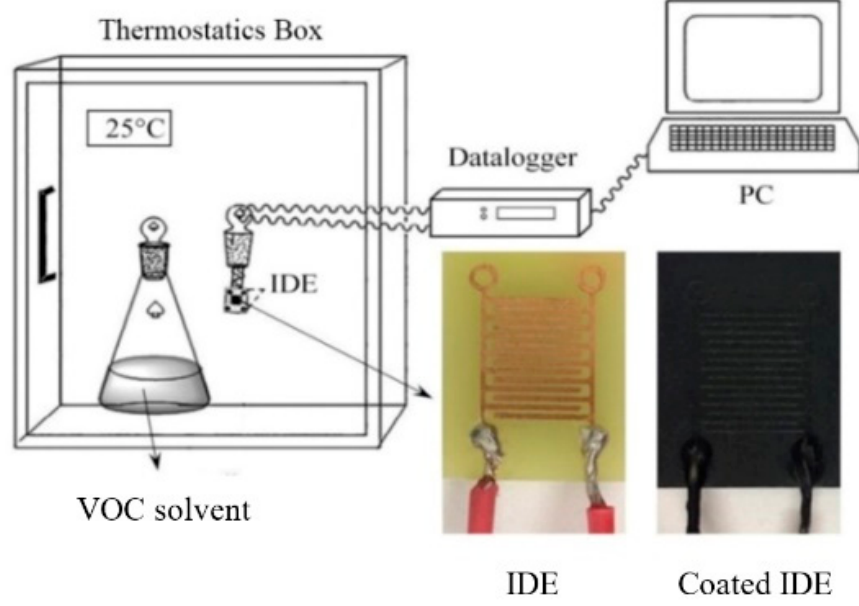
Figure 2. The experimental set-up for the measurement of the electrical resistance response of composite-coated on the interdigitated electrode to the ambient chemical vapors during desorption. The photos show an interdigitated electrode (IDE) and the composite-coated IDE.